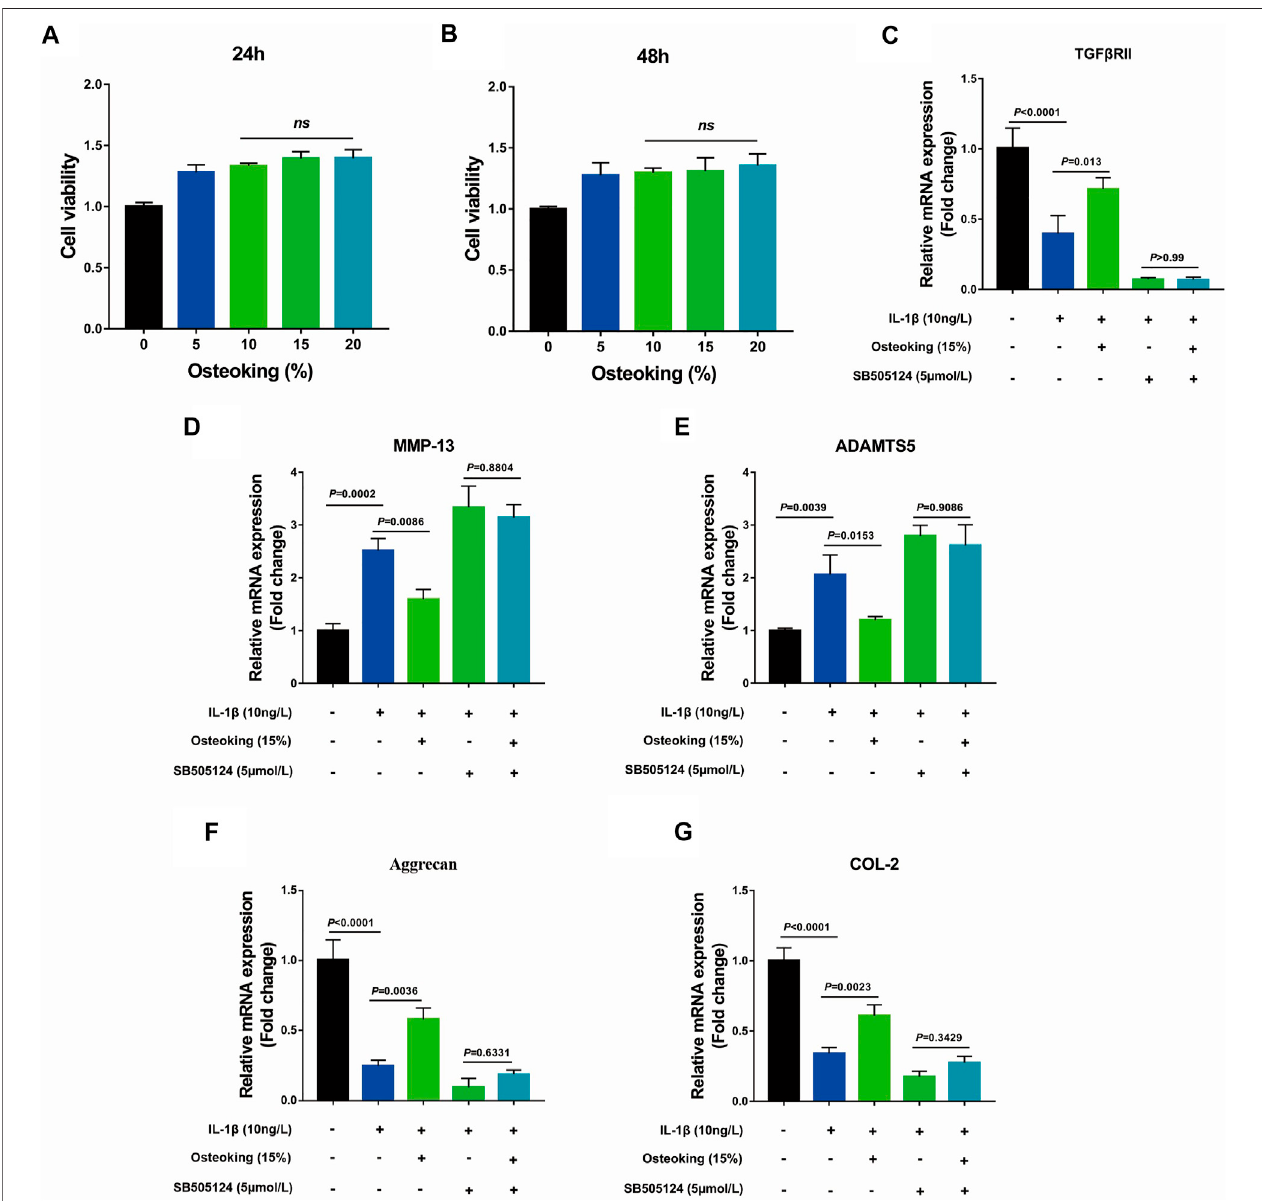
FIGURE 4 | The effect of Osteoking on IL-1 β -induced primary rat chondrocytes in vitro . (A – B) Cell viability of primary rat chondrocytes cultured with various concentrationsofOsteokingfor24and48 h (C – G) ThegeneexpressionofIL-1 β -inducedprimaryratchondrocyteswastreatedwith15%OsteokingandTGF- β inhibitor (SB505124) for 24 h. The Data are presented as means ± SD (n (cid:2) 3 in each group). The exact p value is presented in the corresponding graph.